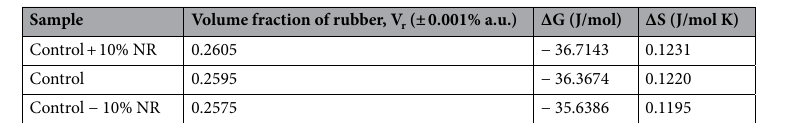
Table 4. Thermodynamic parameters determined from the crosslinking density of various foam samples based on the Flory–Huggins equation 32,33 .